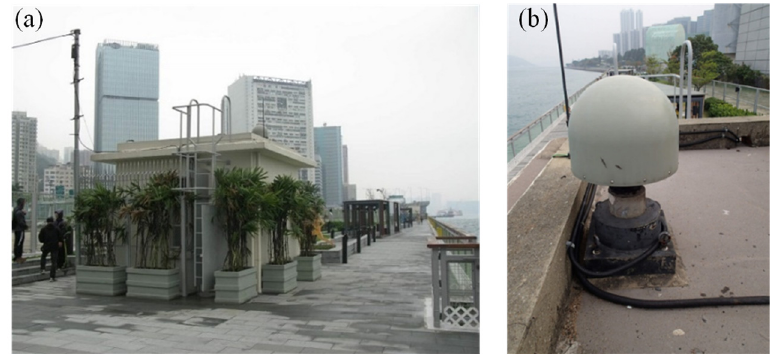
Figure 2. ( a ) Photo of the building on top of which the GNSS receiver was erected and ( b ) photo of GNSS receiver.